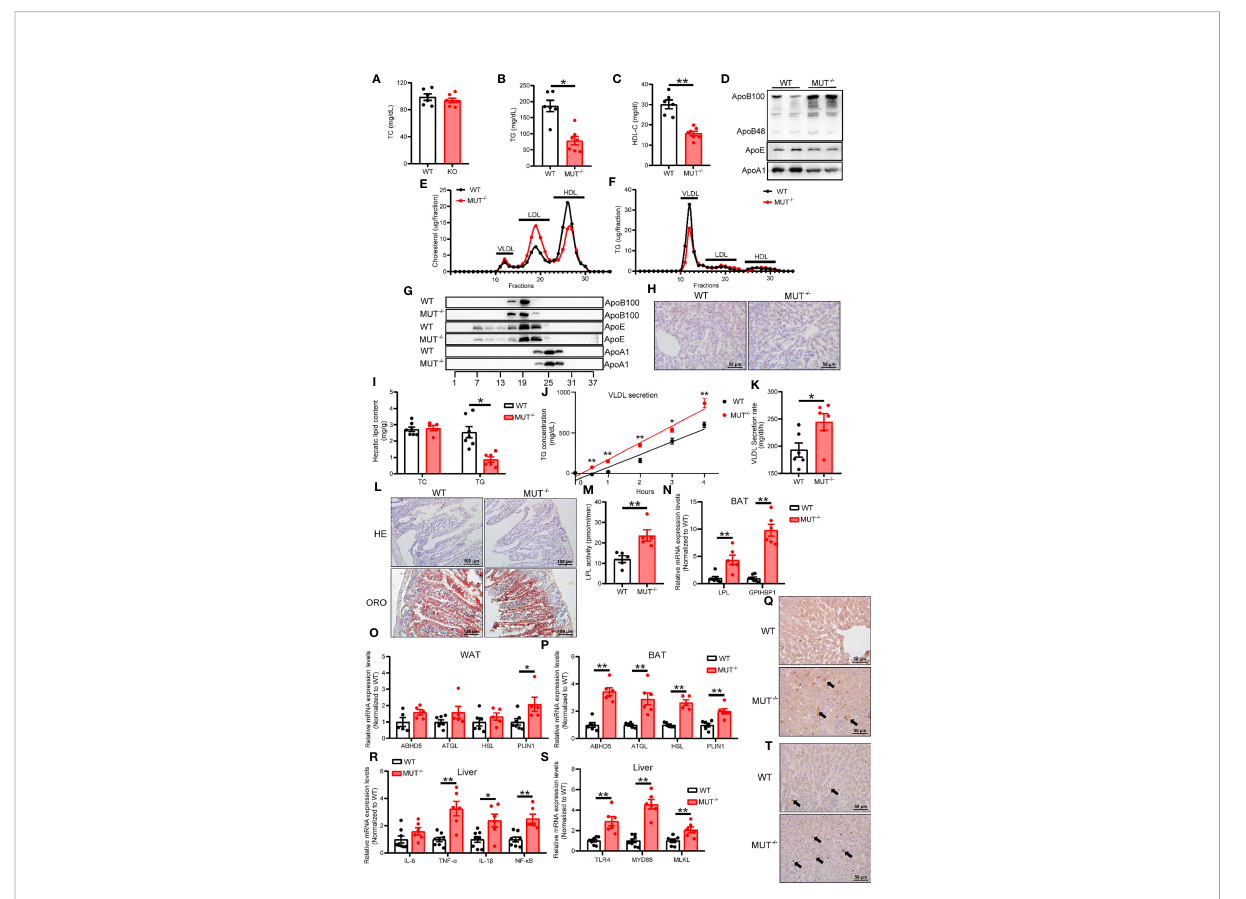
FIGURE 5 Chow-fed IL-10 MUT/MUT hamsters displayed abnormal lipid metabolism. (A, B and C) Determination of plasma TC (A) , TG (B) and HDL-C (C) from 3-month old WT and IL-10 MUT/MUT hamsters on chow diet after overnight fasting (n=6~7/group). (D) Representative Western blots of plasma ApoB, ApoE and ApoA1 from WT and IL-10 MUT/MUT hamsters. (E, F) Pooled plasma from the two groups were analyzed by FPLC. Triglyceride (E) and cholesterol (F) contents in different fractions of pooled plasma from WT and IL-10 MUT/MUT hamsters were measured (n = 6/ group). (G) Representative Western blots of ApoB, ApoE and ApoA1 in different fractions of pooled plasma from WT and IL-10 MUT/MUT hamsters as described in Figures 5E, F. (H) Cryo-sectionings of liver tissues were stained with oil red O. Bars: 50 m m. (I) Hepatic TC and TG contents were measured and normalized to liver weight (n=6~7/group). (J, K) VLDL secretion was analyzed in hamsters after intraperitoneal injection P- 407 (1500 mg/kg, n=6/group). (L) HE and Oil red O stainings of intestinal tissues of WT and IL-10 MUT/MUT hamsters 4 h after oral gavage of olive oil (10 ml/kg body weight). (M) Measurement of plasma LPL activities were in WT and IL-10 MUT/MUT hamsters. (N) Expression levels of LPL and GPIHBP1 in BAT were determined by real-time PCR (n=5/group). (O, P) Expression levels of genes involved in lipolysis in WAT (O) and BAT (P) were determined by real-time PCR (n=5/group). (Q) Immunohistochemistry of LPS in the liver from WT (top) and IL-10 MUT/MUT (bottom) hamsters. Bars: 50 m m; arrows indicate positive staining. (R) Expression levels of TLR4, MYD88 and MLKL in liver were determined by real-time PCR (n=6~7/group). (S) Expression levels of in fl ammatory factors in liver were determined by real-time PCR (n=6/group). (T) Immunohistochemistry of CD68 in the liver from WT (top) and IL-10 MUT/MUT (bottom) hamsters. Bars: 50 m m; arrows indicate positive